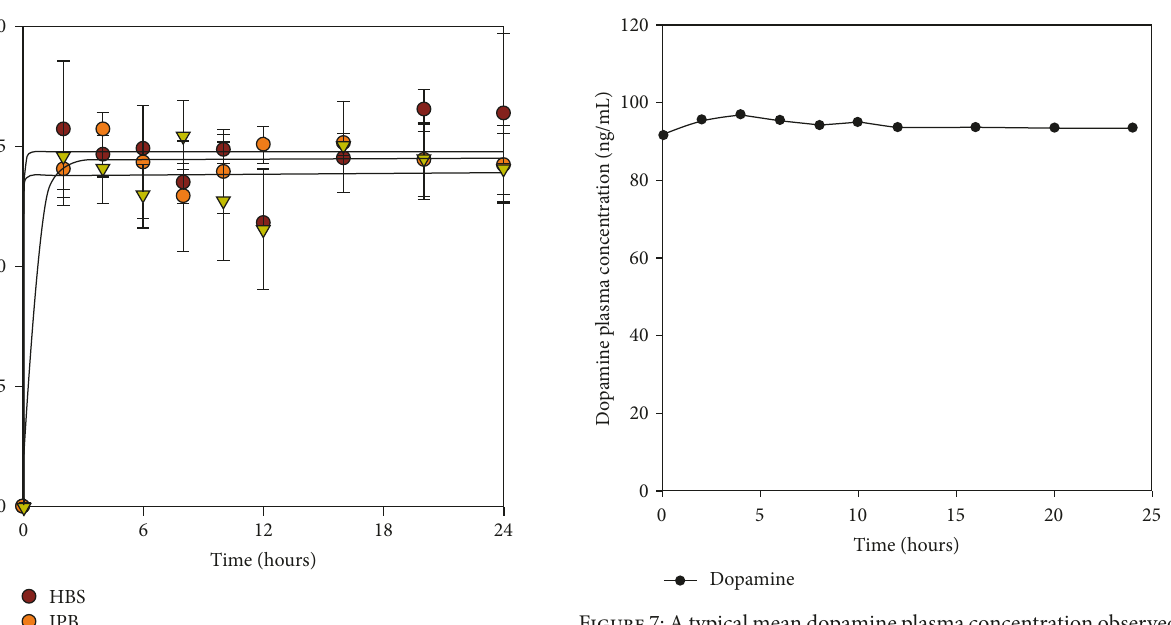
Figure 7: A typical mean dopamine plasma concentration observed for all formulations.